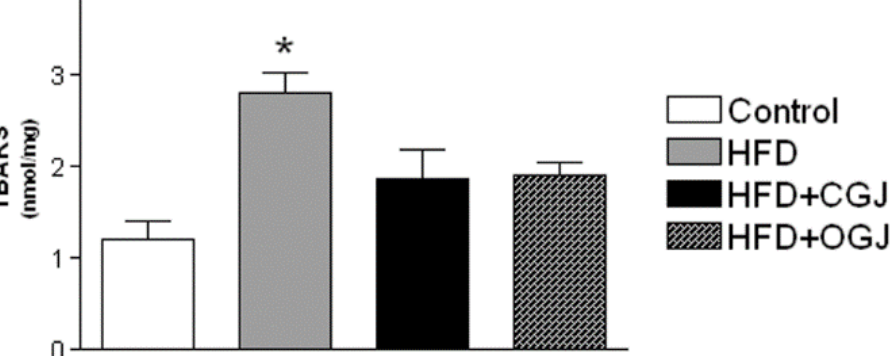
Figure 3. Effect of chronic treatment with high-fat diet and purple grape juices on thiobarbituric acid reactive substances (TBARS) in serum of rats. Values are means ± SEM for 8–10 samples in each group expressed as nmol/mg. Statistically significant differences were determined by ANOVA followed by Bonferroni test: * p < 0.05, from other groups. HFD: high-fat diet; CGJ: conventional grape juice; OGJ: organic grape juice.